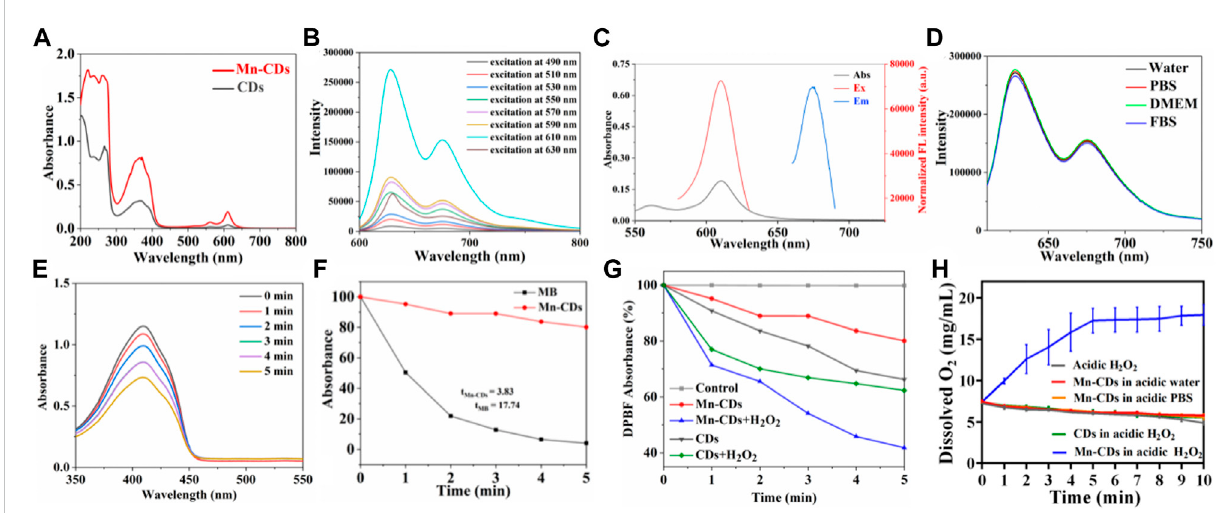
FIGURE 2 Thephotoactivecharacteristicsandstability ofMn-CDsandCDs. (A) UV – VISspectrumMn-CDsandCDsinaqueoussolution. (B) TheFLofMn-CDs (C) The absorption spectrum, excitation, and emission spectra of Mn-CDs in aqueous solution. (D) PL spectra of Mn-CDs in different media. (E) Absorption spectra of DPBF mixed with the Mn-CDs under 635 nm laser irradiation. (F) Decay curves of the DPBF absorption at 412 nm as a function